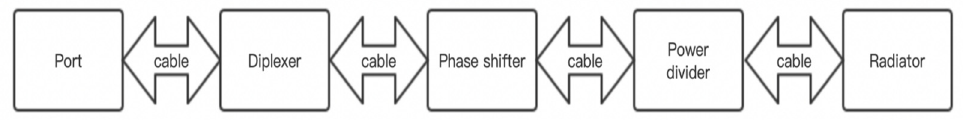
Figure 3. Transmission path of the typical antenna.